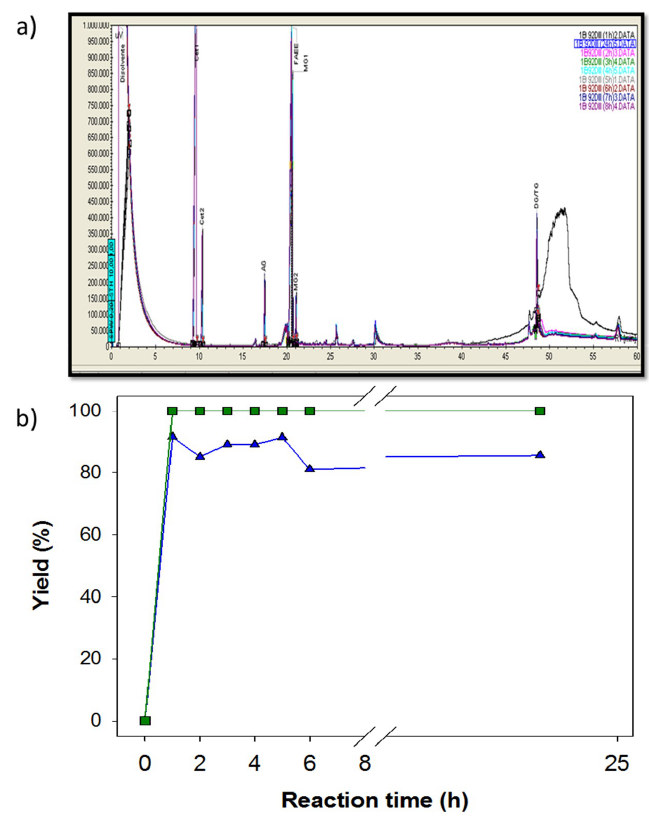
Figure 5. ( a ) Superimposed chromatograms corresponding to the ethanolysis reaction of sunflower oil, under standard conditions over the OS-8 wild microbial strain extract, at different reaction times. ( b ) Conversion (green squares) and selectivity (blue triangles) values obtained from these chromatograms.